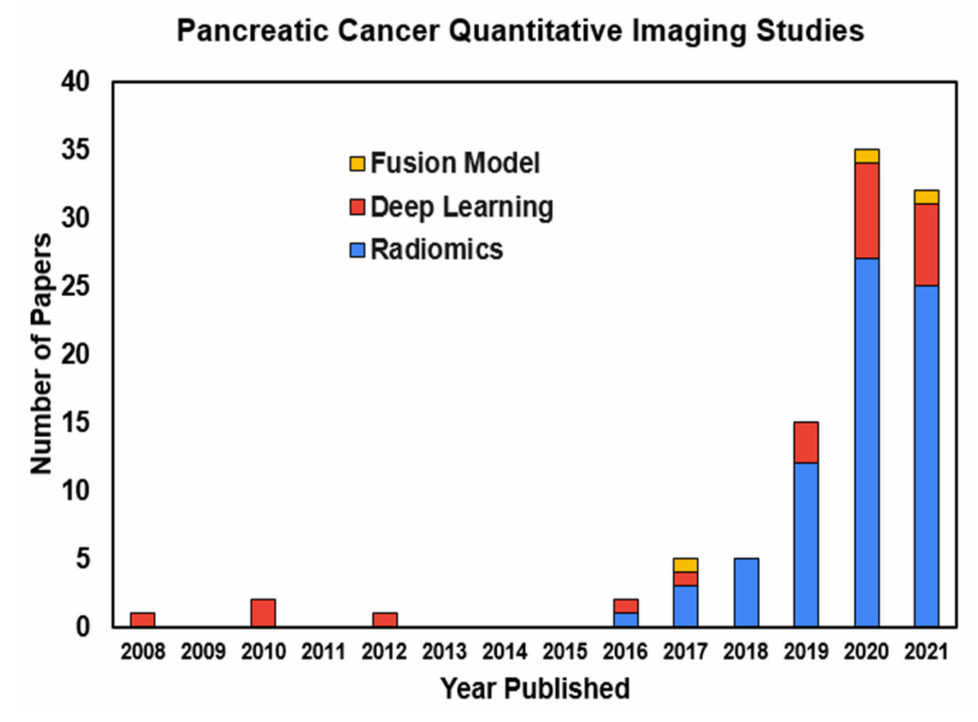
Figure 2. Quantitative imaging studies using radiomics and deep learning methods in pancreatic cancer-related research by year of